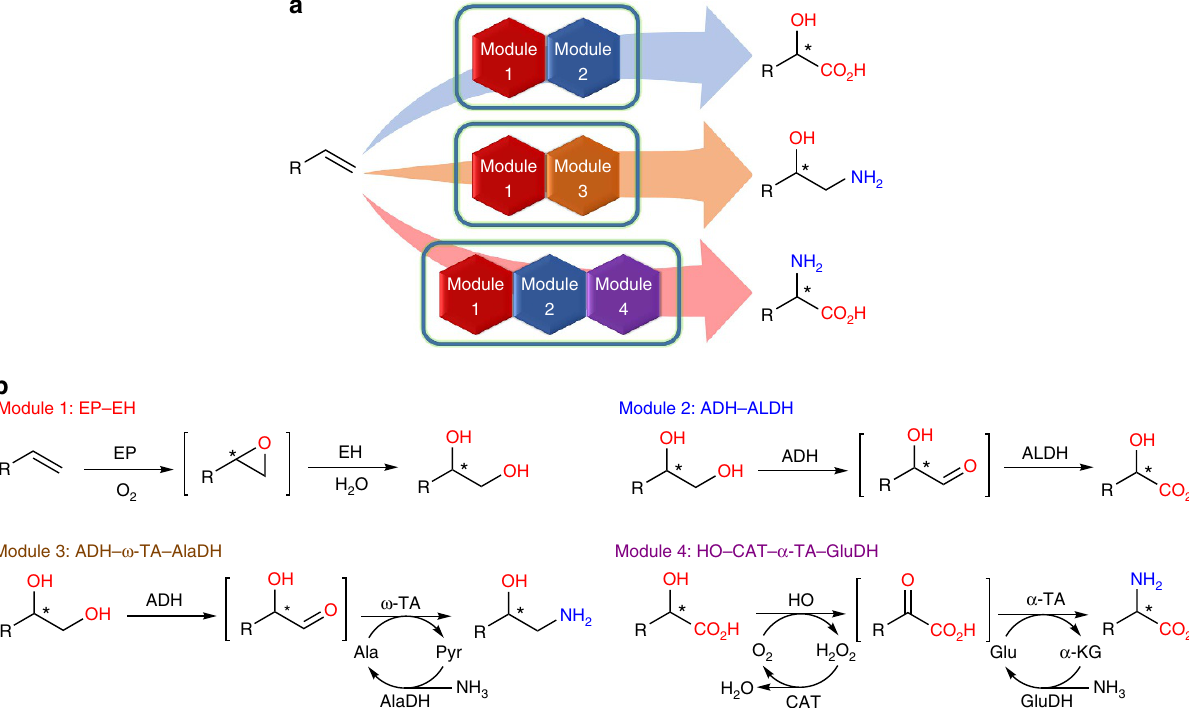
Figure 1 | Regio- and enantioselective multiple oxy- and amino-functionalizations of terminal alkenes by modular cascade biocatalysis. ( a ) One-pot conversion of terminal alkene to chiral a -hydroxy acid, 1,2-amino alcohol and a -amino acid with E. coli cells containing multiple basic enzyme modules, respectively. ( b ) Four general basic enzyme modules and their cascade biotransformations. Module 1: epoxidase (EP) and epoxide hydrolase (EH) for epoxidation–hydrolysis of terminal alkene to 1,2-diol; Module 2: alcohol dehydrogenase (ADH) and aldehyde dehydrogenase (ALDH) for terminal double oxidation of 1,2-diol to a -hydroxy acid; Module 3: ADH, o -transaminase ( o -TA) and alanine dehydrogenase (AlaDH) for oxidation–transamination of 1,2-diol to 1,2-amino alcohol; Module 4: hydroxy acid oxidase (HO), a -transaminase ( a -TA), catalase (CAT) and glutamate dehydrogenase (GluDH) for oxidation–transamination of a -hydroxy acid to a -amino